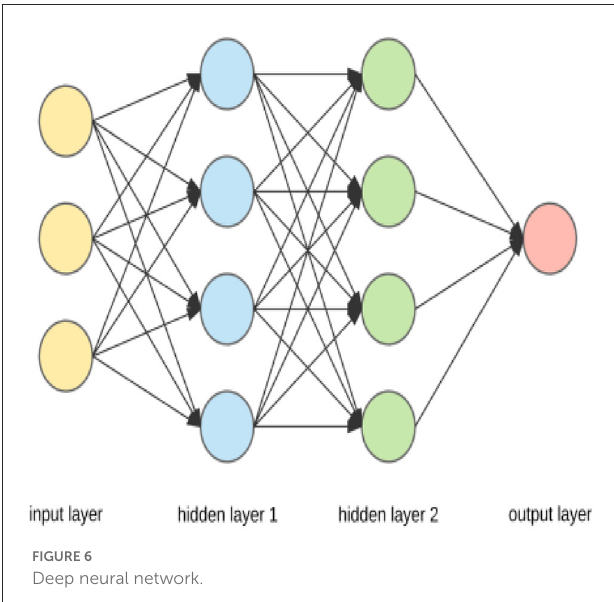
TABLE 6 A subset of the UNSW-NB15 dataset distribution.